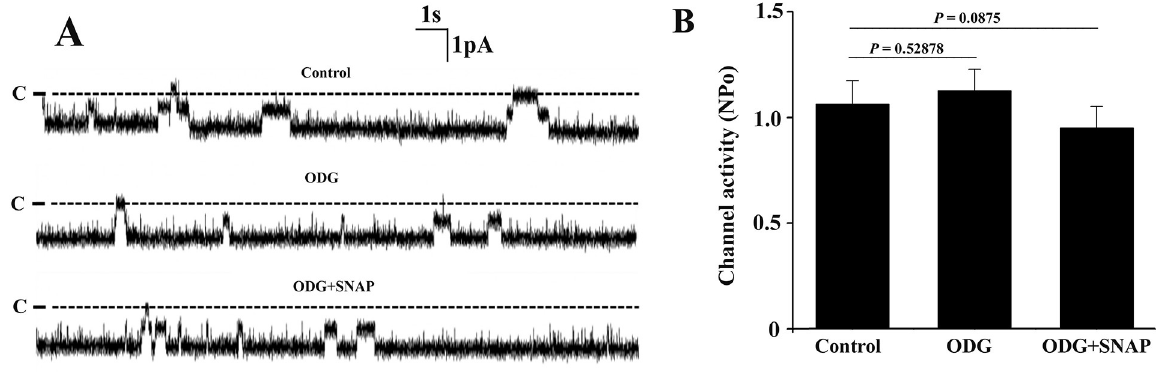
Fig 3. Soluble guanylyl cyclase (sGC) inhibitor ODQ blocks the inhibitory effect of SNAP on the 10-pS Cl - channels in the TAL. (A) Representative single channel recordings from the same cell-attached patch under control condition, in the presence of 10 μ M ODQ alone as well as in the presence of both ODQ (10 μ M) and SNAP (5 μ M). The holding potential was − 60 mV and the channel closed level is indicated by the dotted line and “C”. (B) The bar graph showing that ODG abolishes the inhibitory effect of SNAP on the channels (n = 5).